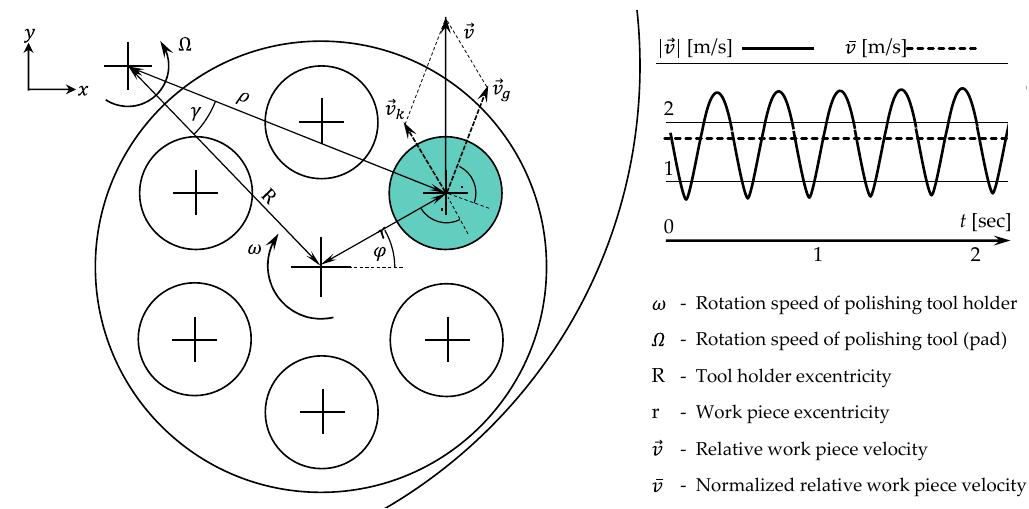
Figure 5. Kinematical analysis of polishing experiments using a flat polishing machine.